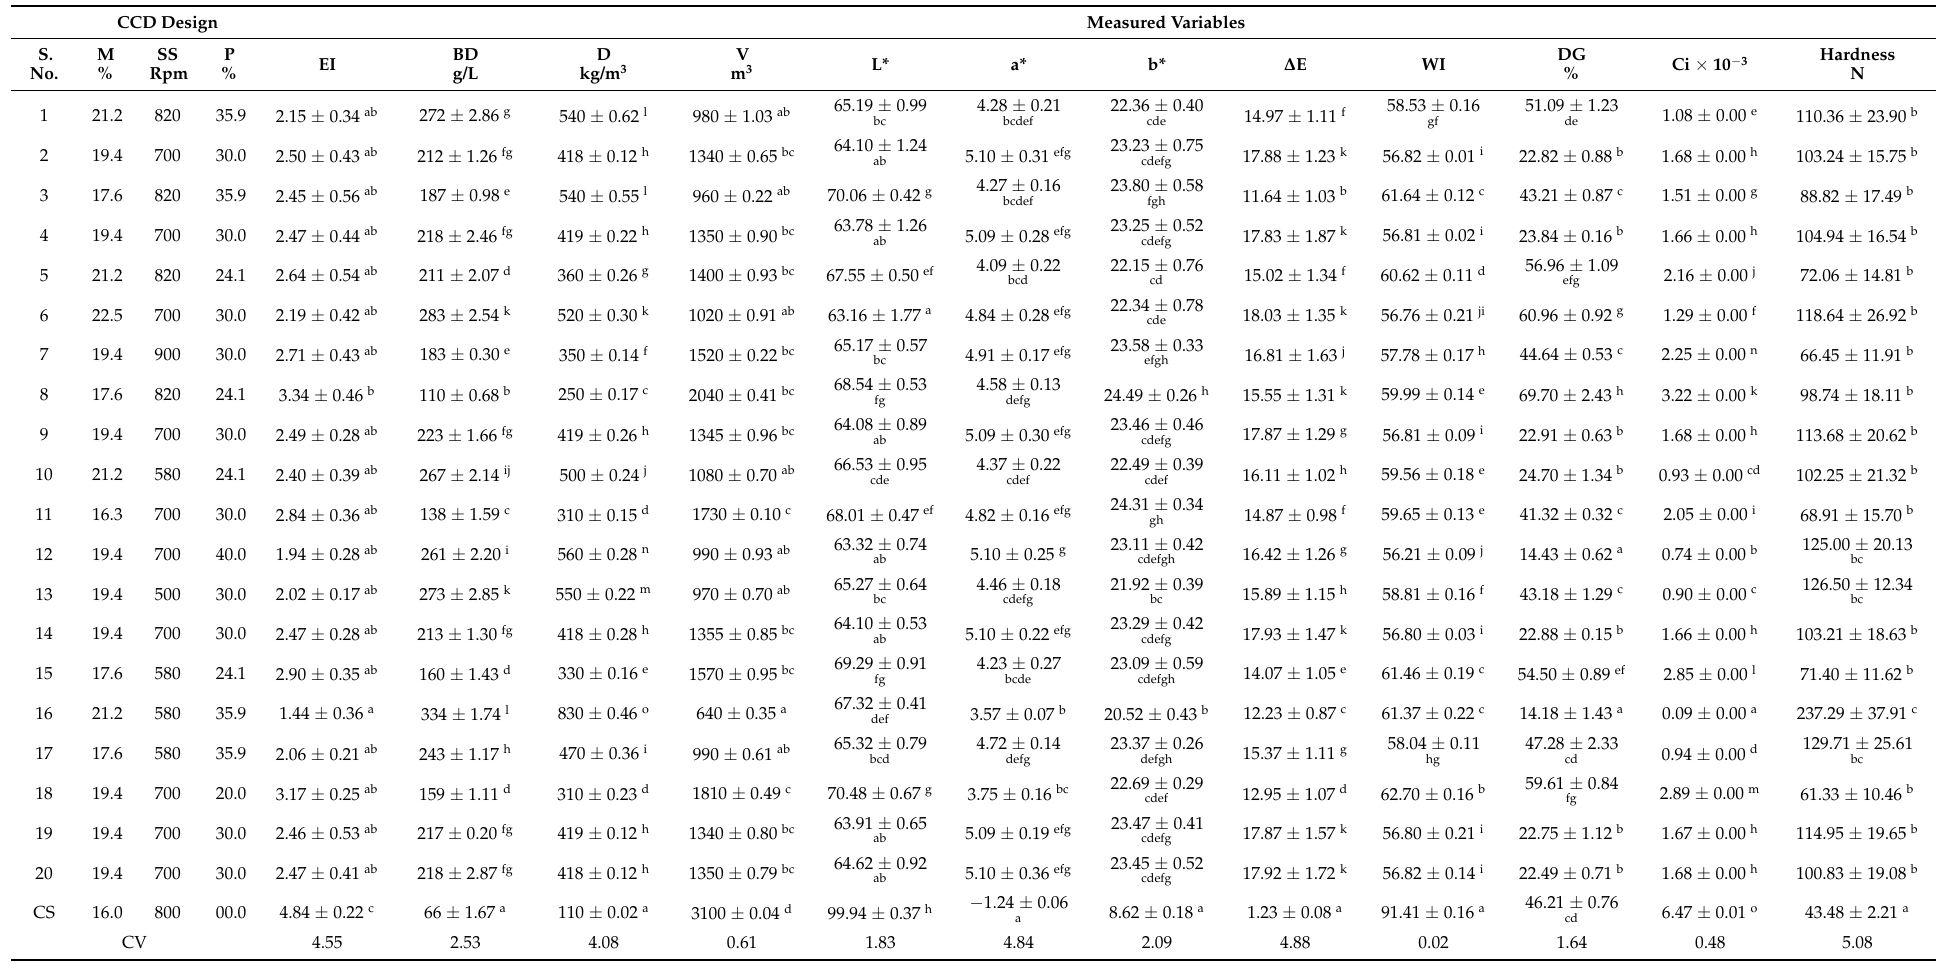
Table 2. CCD design and measured dependent process variables (EI, BD, D, V, color properties), measured thermal (DG) and textural (Ci, Hardness)